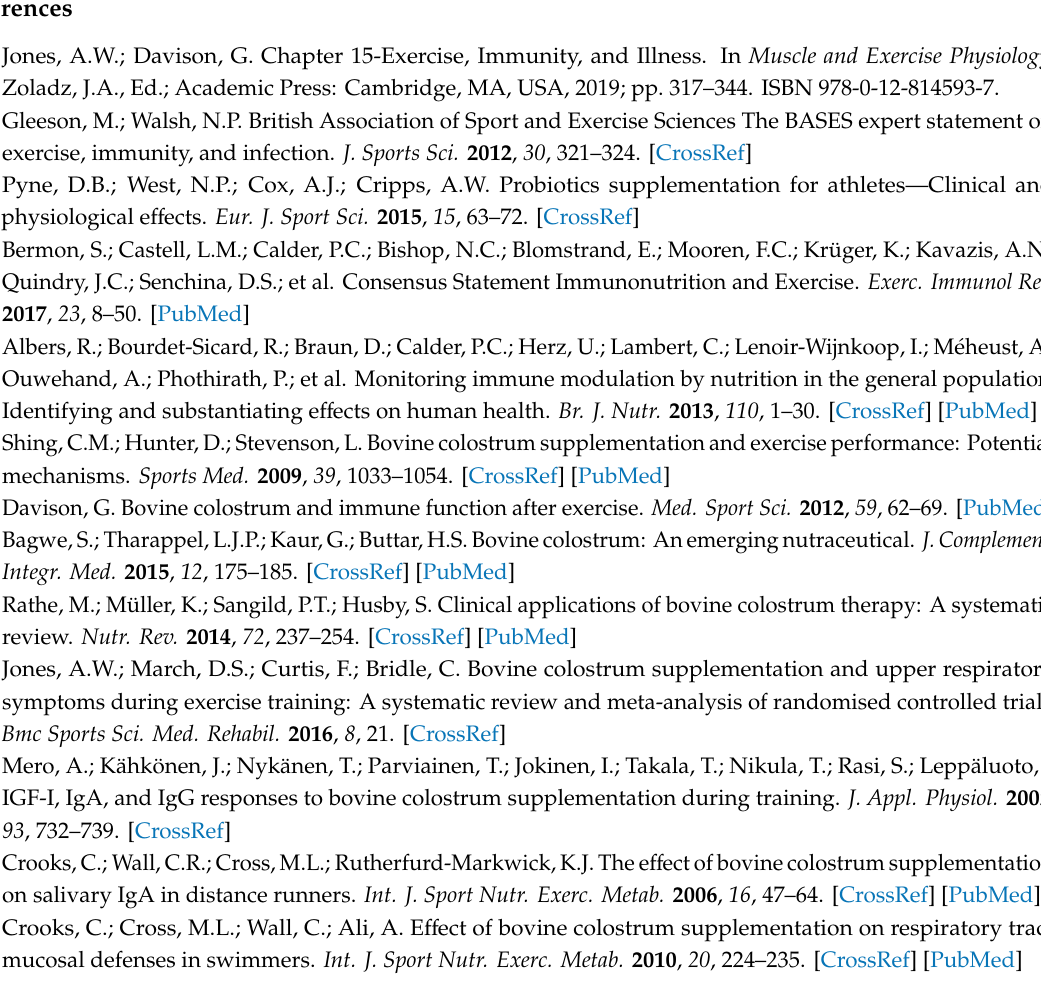
Figure S1. Funnel plot of the random-e ff ects meta-analysis of changes in lymphocytes concentration; Figure S2. Funnel plot of the random-e ff ects meta-analysis of changes in neutrophils concentration; Figure S3. Funnel plot of the random-e ff ects meta-analysis of changes in IgA concentration; Figure S4. Funnel plot of the random-e ff ects meta-analysis of changes in IgG concentration; Figure S5. Funnel plot of the random-e ff ects meta-analysis of changes in pre-exercise SIgA concentration; Figure S6. Funnel plot of the random-e ff ects meta-analysis of changes in post-exercise SIgA concentration; Figure S7. Funnel plot of the random-e ff ects meta-analysis of changes from baseline to post-supplementation in pre-exercise SIgA concentration; Figure S8. Funnel plot of the random-e ff ects meta-analysis of changes from baseline to post-supplementation in post-exercise SIgA